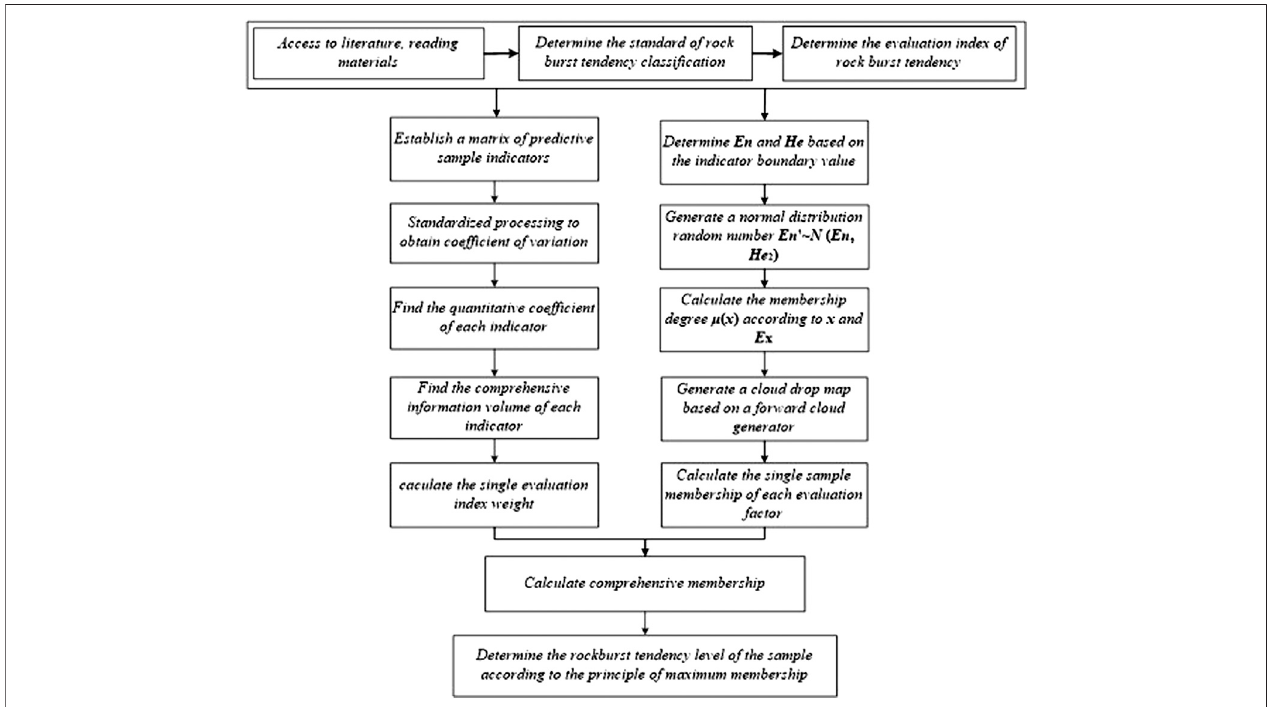
FIGURE 4 | Flow chart of rock burst tendency prediction and